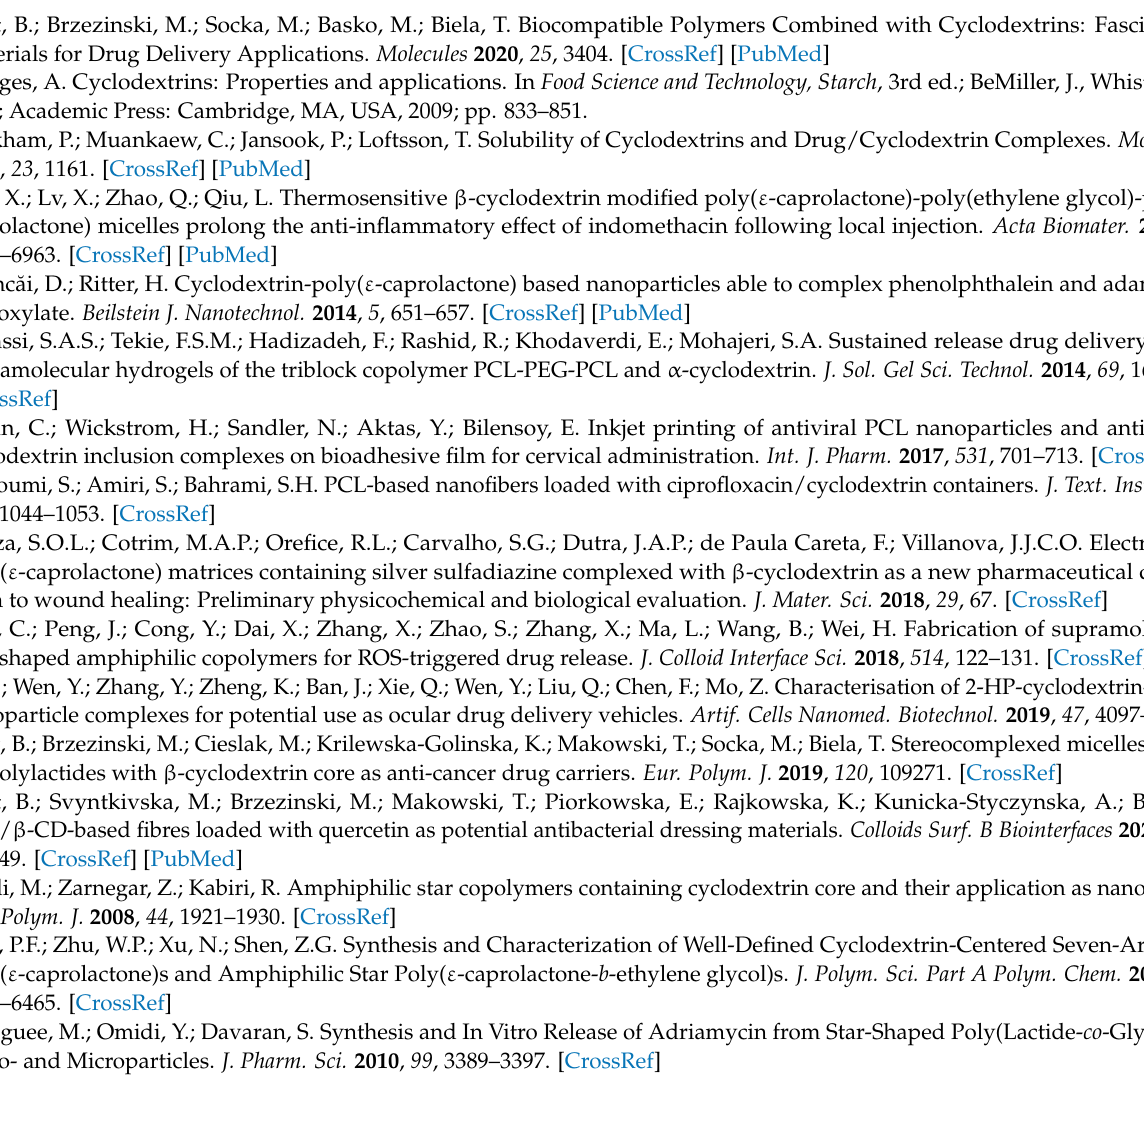
Figure S13: MS/MS spectrum of [CDCL 5 -F 1 + Na] + ; Figure S14: MS/MS spectrum of [CDCL 5 -F 2 + Na] + ; Figure S15: Dispersity index evolution